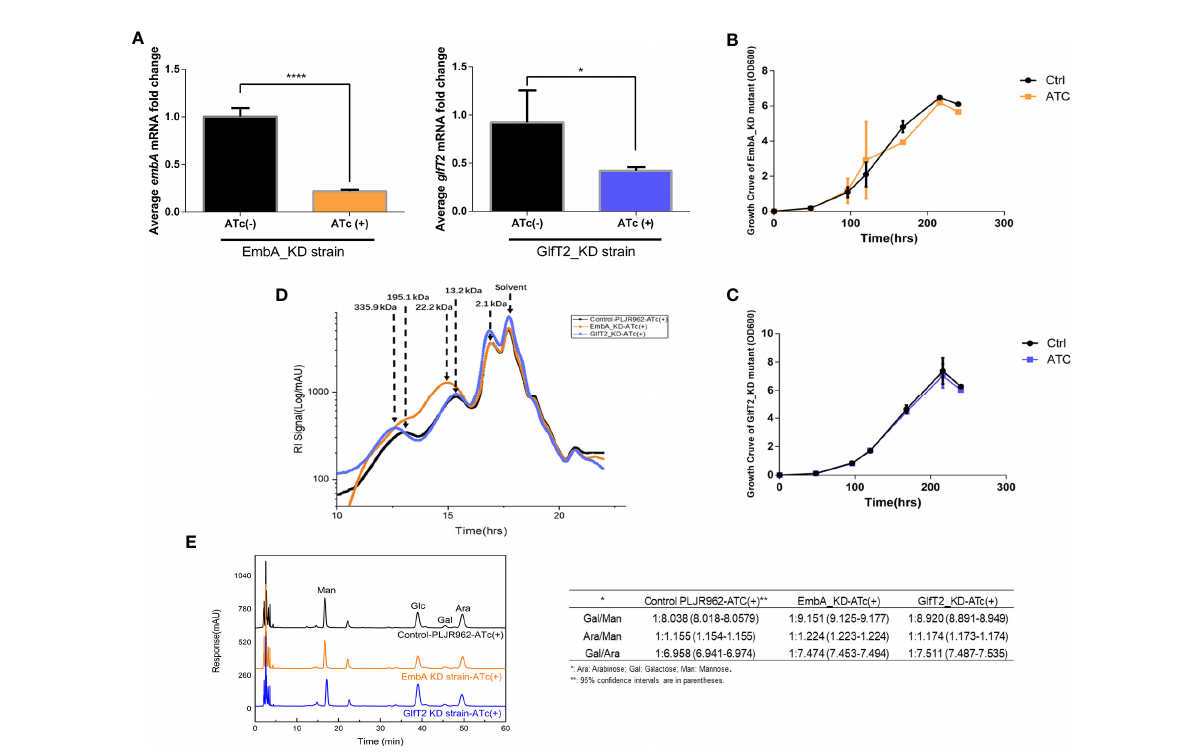
FIGURE 1 Construction of conditional EmbA/GlfT2_KD strains and validation of impaired arabinogalactan synthesis in Mycobacterium marinum cell wall. (A) qPCR proved the corresponding relative expression of embA or glfT2 of embA knock-down (EmbA_KD) or glfT2 knock-down (GlfT2_KD) strains with or without anhydrotetracycline (ATc) induction at logarithmic growth stage. Data are plotted as mean ± standard deviation (SD), unpaired t -test: **** p < 0.0001, * p = 0.0236. (B, C) Growth curves of EmbA/GlfT2_KD strain with or without ATc induction. Absorbance (OD 600 ) measured in the bacterial liquid re fl ects the growth. (D) High-performance gel permeation chromatography was used to analyze the polysaccharide molecular weights of knock-down strain cell walls. The linear regression equation of retention time ( t R ) and relative molecular weight (MW) of polysaccharide is logMW = -0.5042 t R + 11.884. Relative molecular weights corresponding to peaks are marked. (E) High- performance liquid chromatography was used to analyze the monosaccharide contents in the cell walls of control and knock-down strains. The peak area integral was used to calculate the proportion of each monosaccharide, and the ratios of arabinose – galactose/mannose or galactose/ arabinose were calculated. The calculation results are presented in the